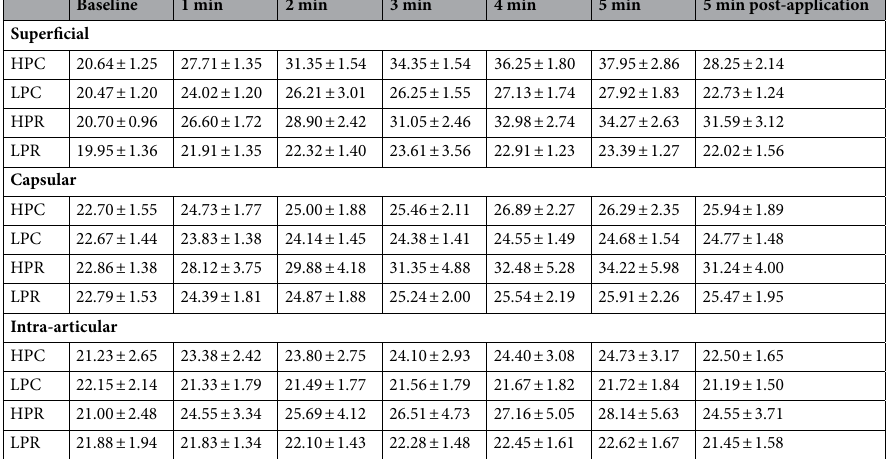
Table 2. Descriptive outcomes: temperature (°C). HPC high-power capacitive, LPC low-power capacitive, HPR high-power resistive, LPR low-power resistive.